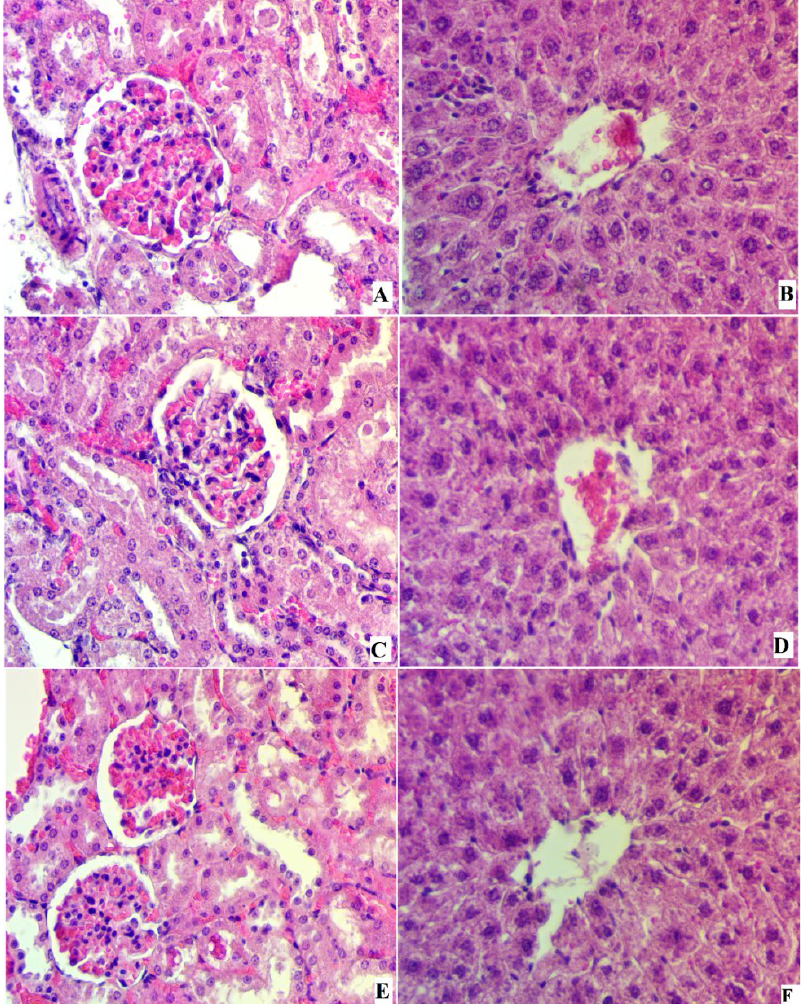
Figure 2. Histological sections of kidney (first column) and liver (second column) in the acute toxicity test (H&E staining, 40×). Rats treated with 5 mL/kg vehicle (0.5% CMC) ( A , B ); rats treated with 250 mg/kg (5 mL/kg) ( C , D ); rats treated with 500 g/kg (5 mL/kg) ( E , F ). No significant changes were observed in the structures of livers and kidneys between the treated and control groups (H&E staining, 40 ×